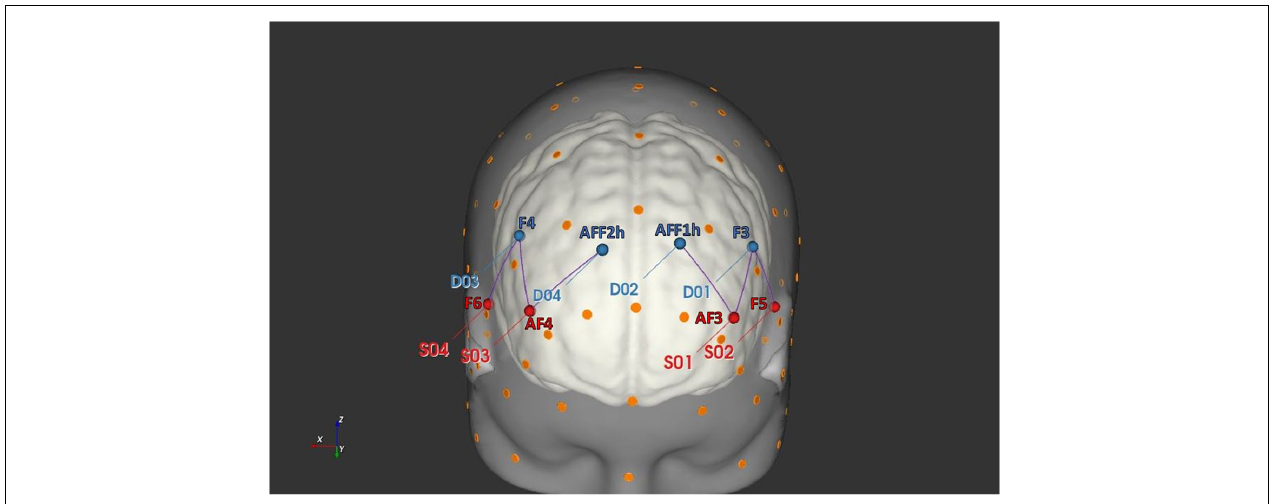
FIGURE 2 | fNIRS head probe placement. The head rendering has been generated with the software NIRSite (NIRx Medical Technologies LLC) and it displays the position of the fNIRS sources (in red) and detectors (in blue).